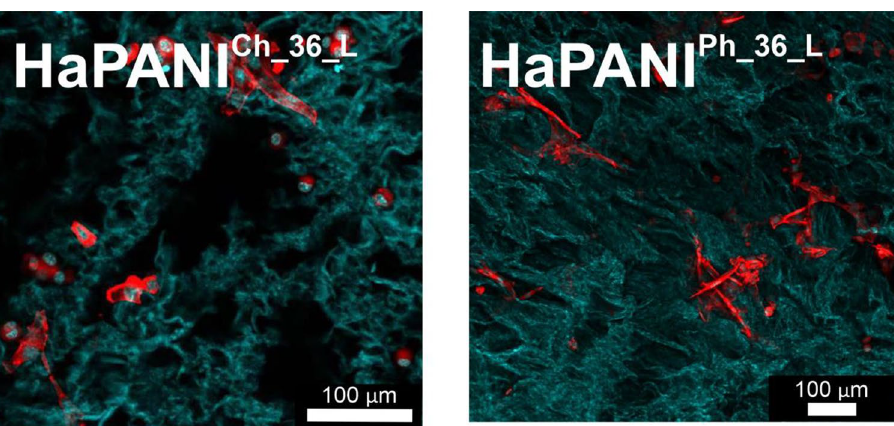
Figure 11. The morphology of cells within the structure of scaffolds. Cell nuclei were counterstained with Hoechst (blue); the cytoskeleton was counterstained with actin red (red). The green colour represents the hydrogel structure. Cells were seeded onto the surface of scaffolds before cultivation in a bioreactor. The images were taken from the cross-sections of scaffolds, namely from the centre of sample and 0.5 cm below the surface. The images thus represent cells which grow into the structure of scaffolds from its